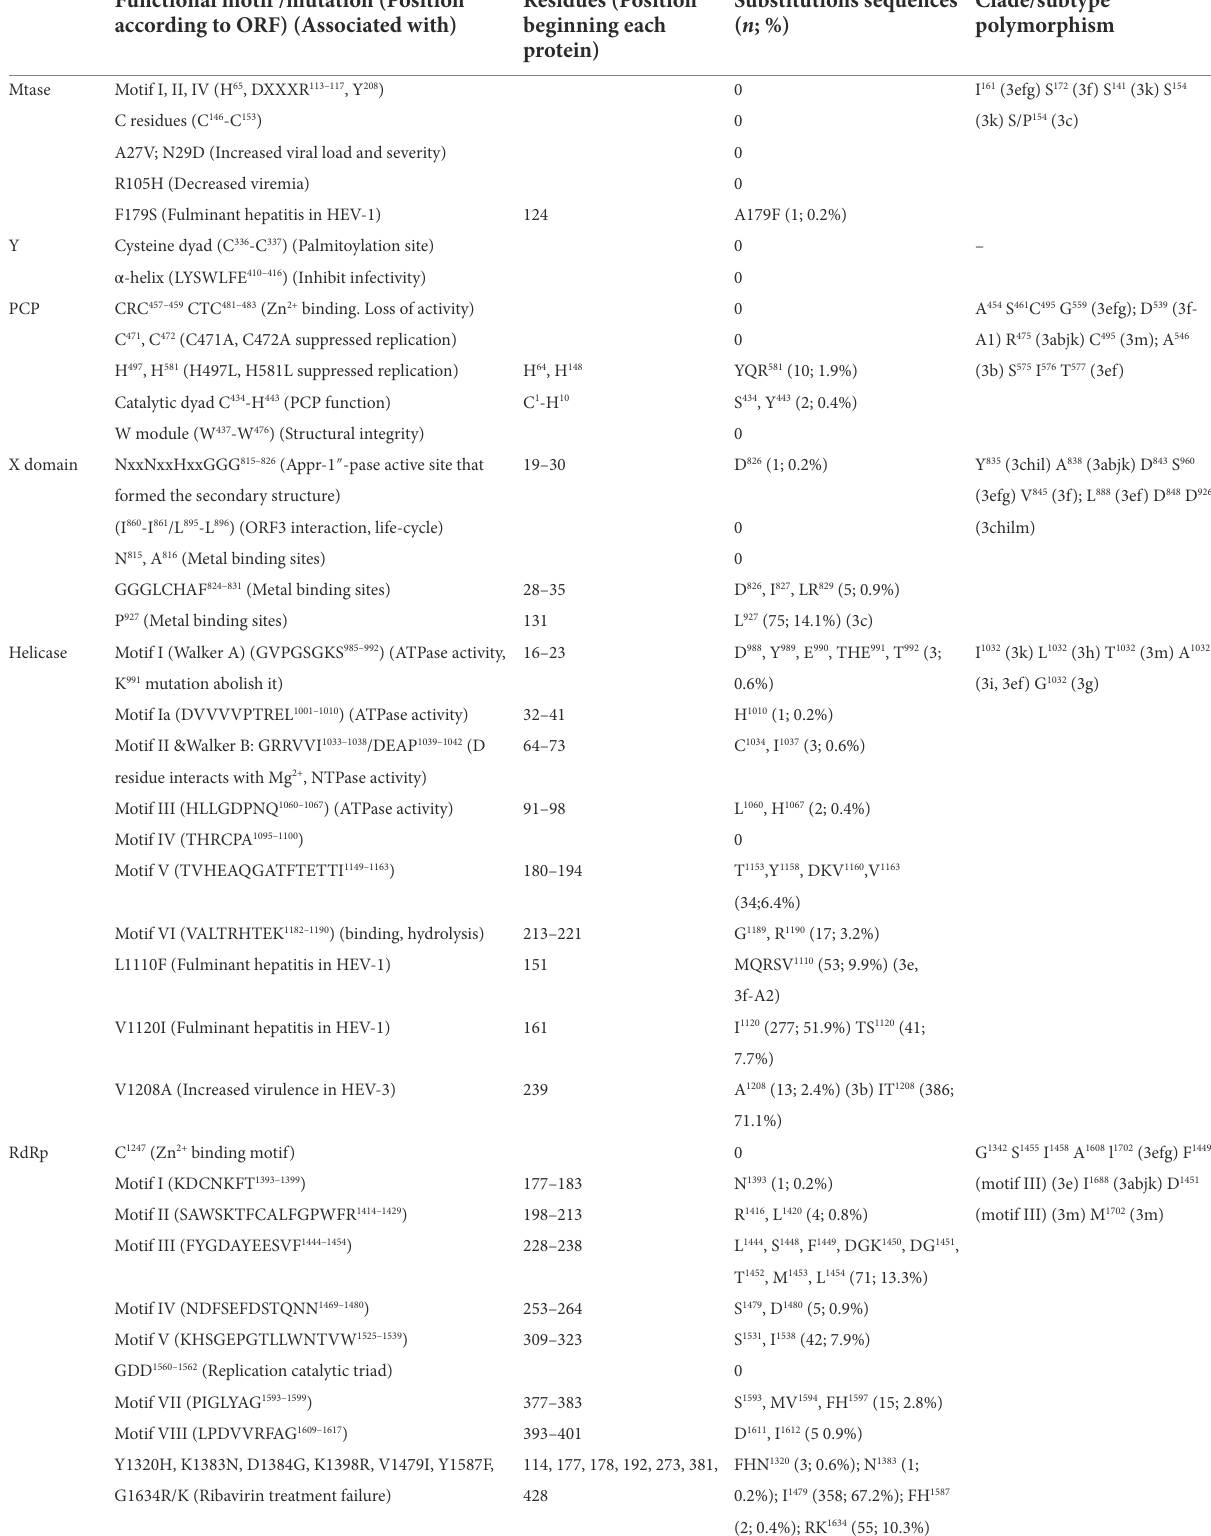
TABLE 2 Analysis of previously reported motifs and mutations of ORF1 of HEV-3 genome (references of motifs and mutation are mentioned in the Introduction and listed in full in Supplementary material). Functional motif /mutation (Position according to ORF) (Associated with)